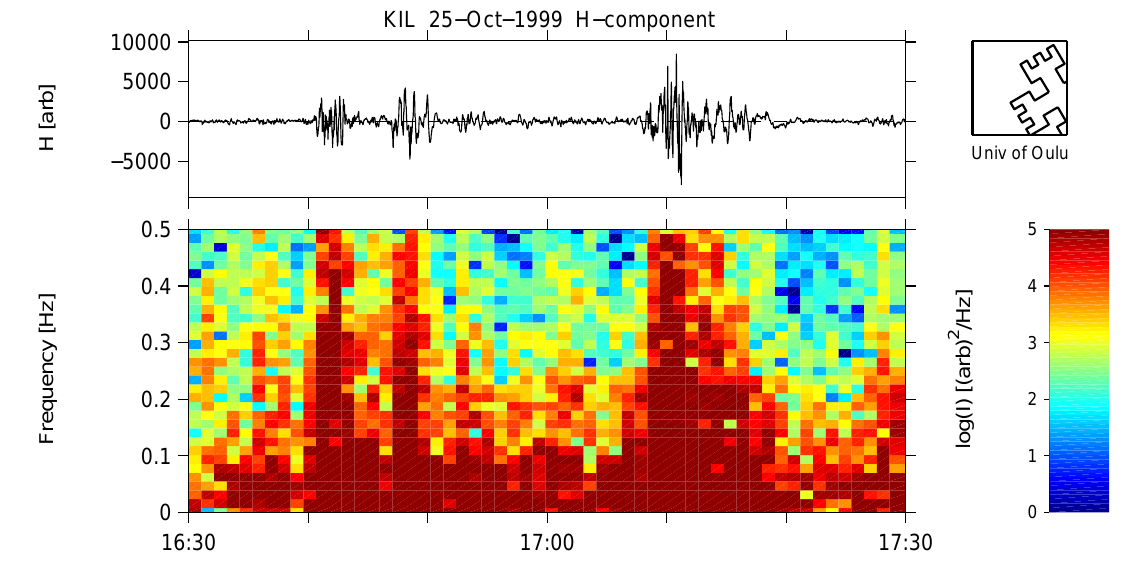
Fig. 4. The H-component of the pulsation magnetometer observations from Kilpisj¨arvi (a) on 5 October 1999 from 19:40 to 20:40 UT and (b) on 25 October 1999 from 16:30 to 17:30 UT is shown in the upper panel. Below, a frequency spectrum for the same time is shown. The four activation regions from the preview figures show significant Pi2 and Pib1 pulsations.